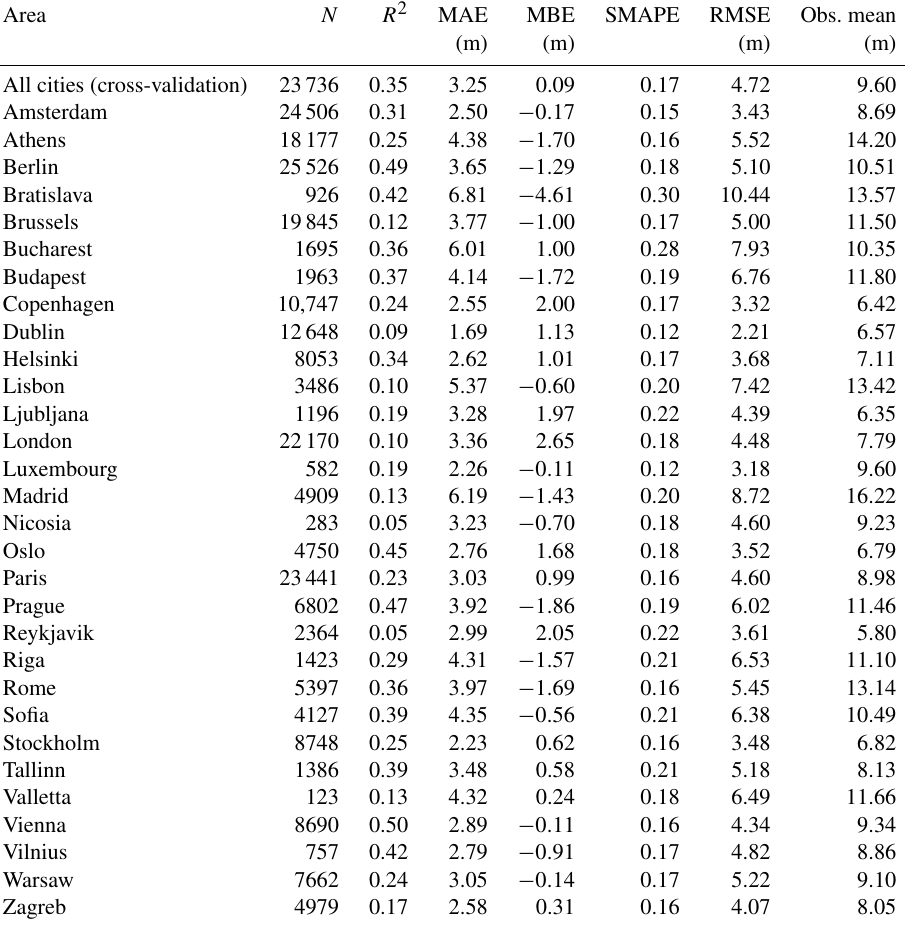
Table 2. Validation statistics for the building height prediction model (mean value of the uncertainty distribution) for different cities. For all cities, the results are an average of results for a 10-fold cross-validation. For individual cities, the results are an out-of-sample validation (i.e. the model’s sample excluded the city that was